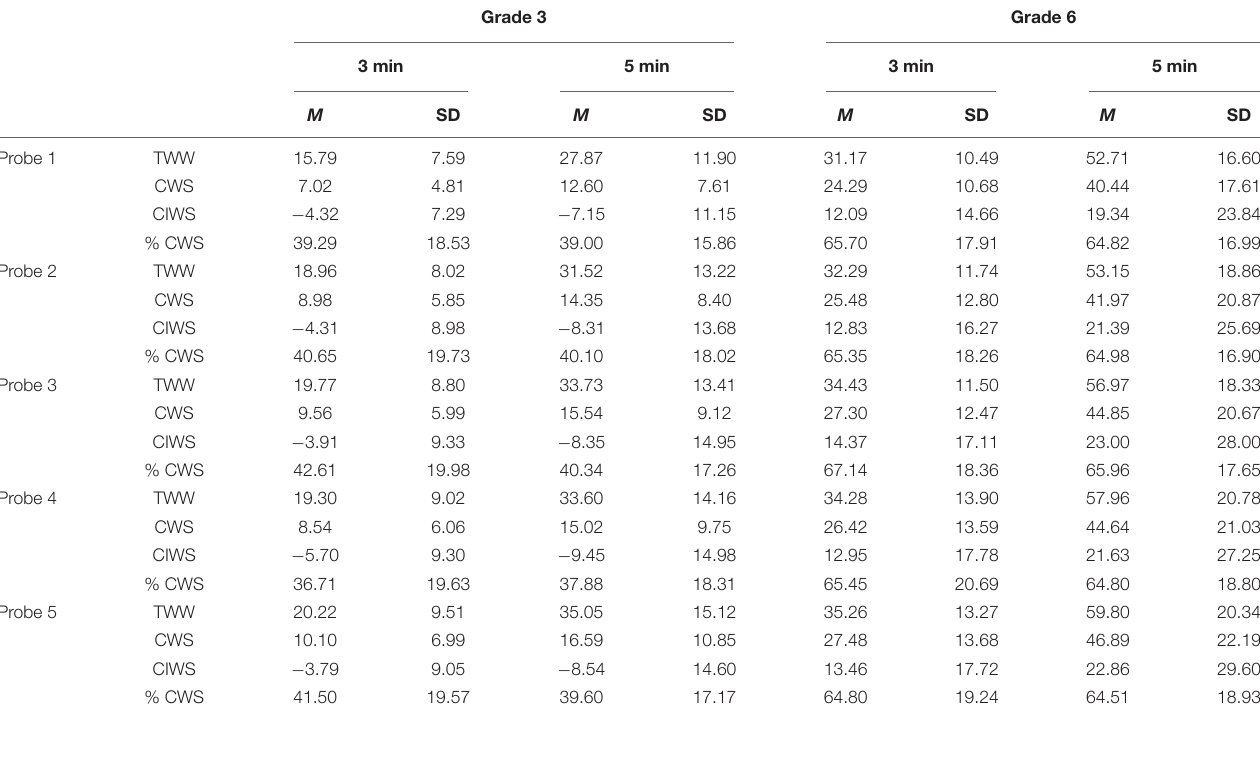
TABLE 2 | Results of the G-studies for 5-min writing samples for TWW, CWS, and CIWS.